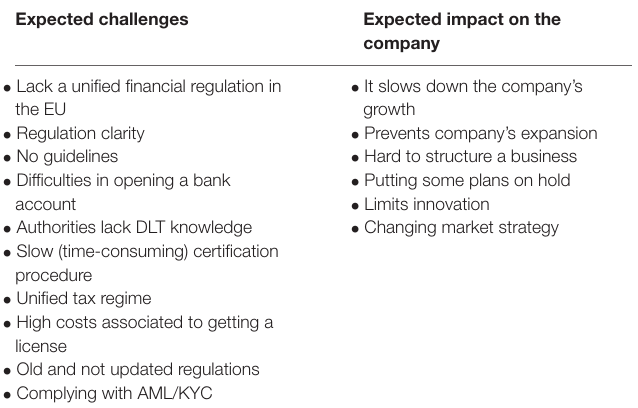
TABLE 2 | Expected financial regulation challenges and their impact on DLT